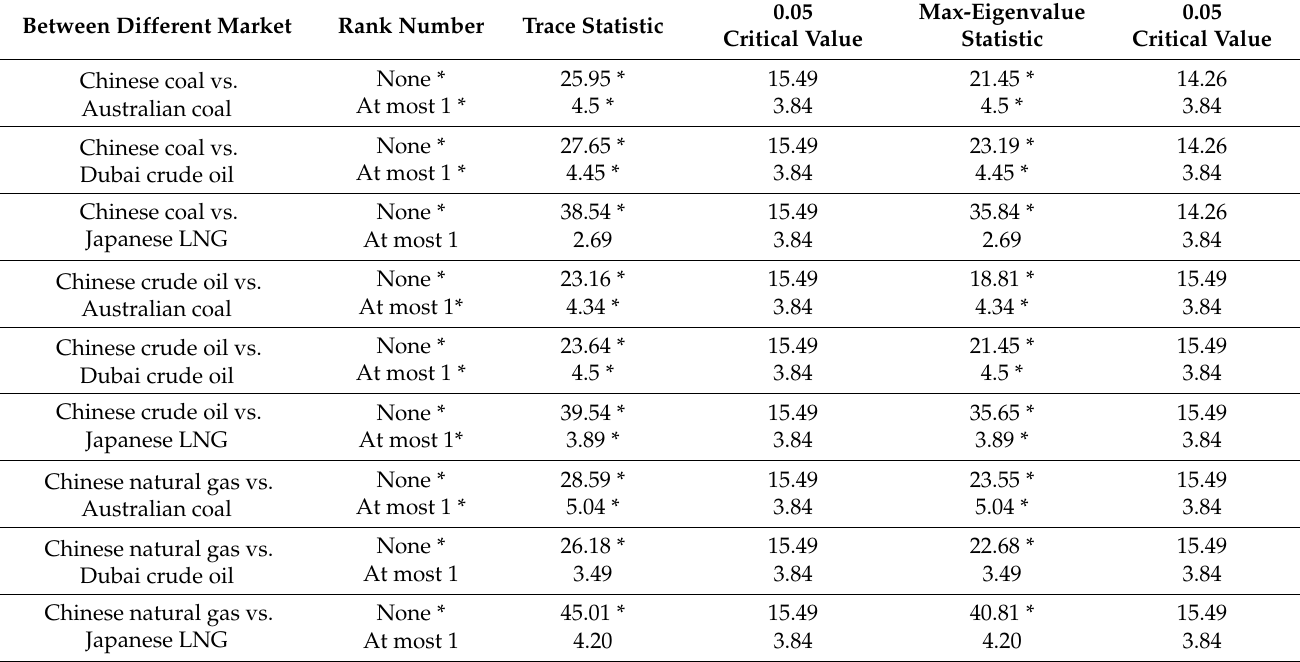
Note: * Significant at the 5% significance